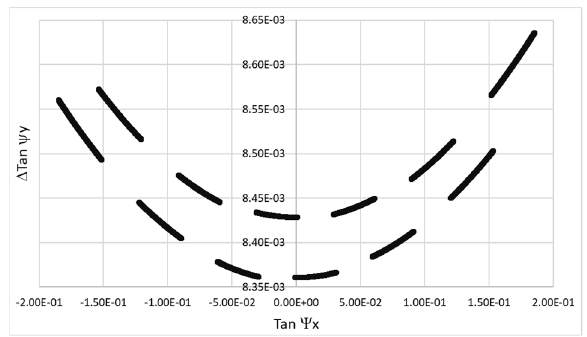
Figure 8 : Absolute difference of B2 and B4 ALT LOS component. The swath range ratio due to distortion is